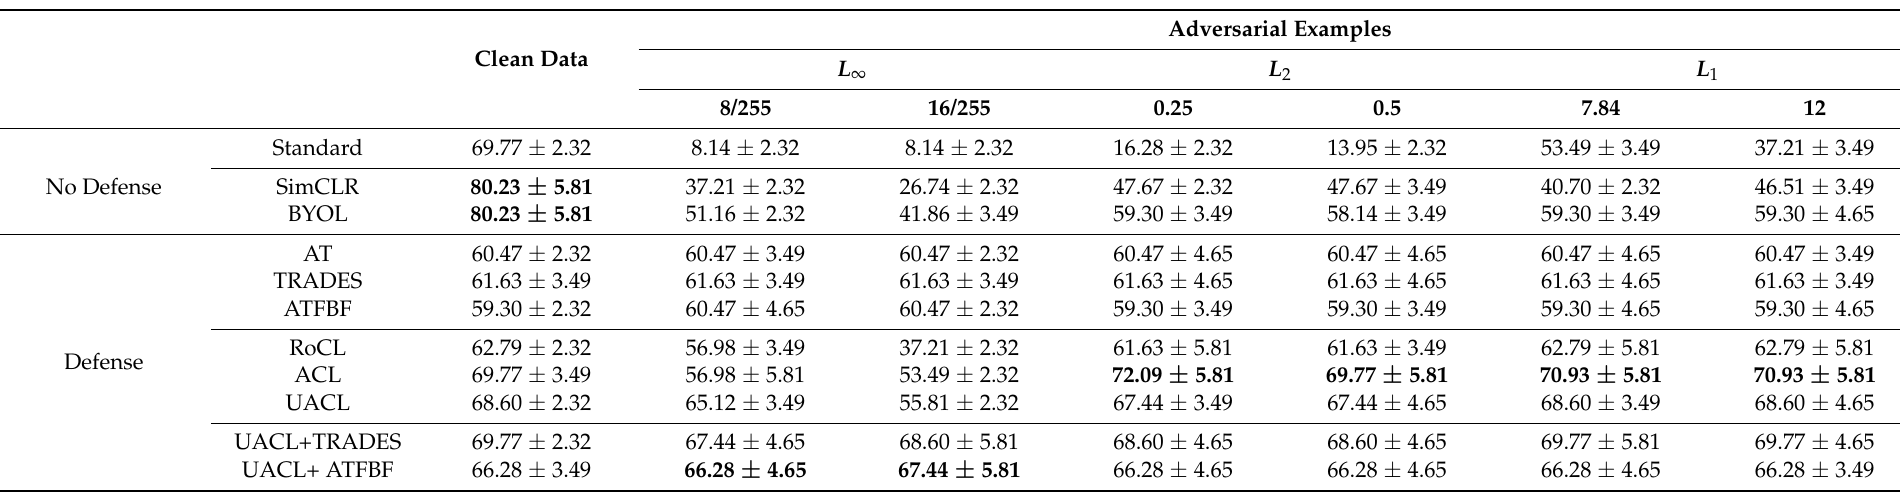
Table 10. Classification accuracy of models (ResNet18) with no-defense or defense methods against PGD adversarial attacks in FUSAR-Ship dataset.